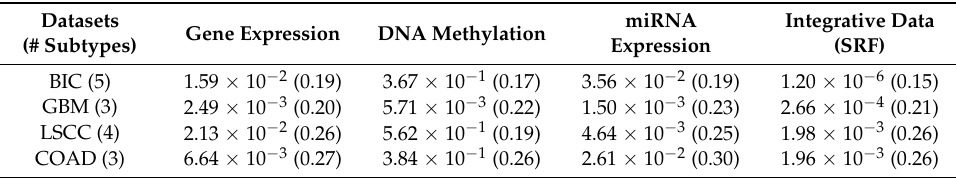
Table 2. The Cox log-rank test p -values in survival analyses for the identified subtypes by using different predicted similarity information in